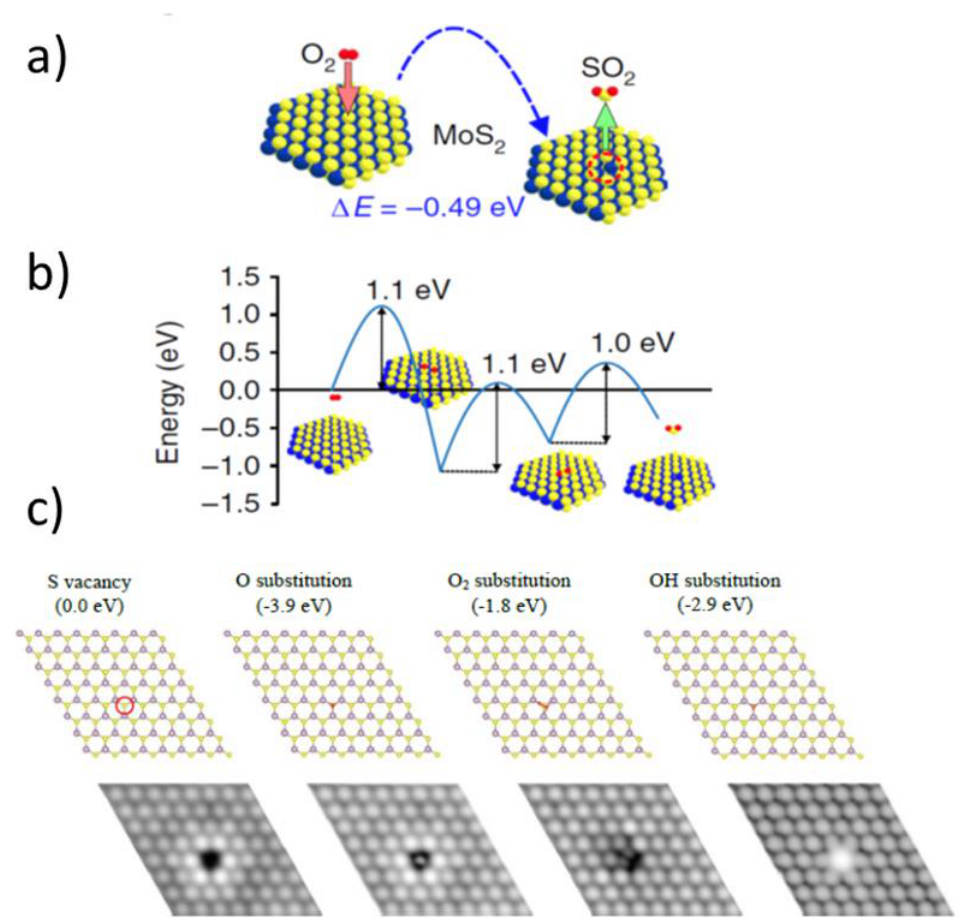
Figure 14. Energetics and kinetics of single sulfur vacancy creation and its later O substitution within the MoS 2 basal plane obtained by Peto et al. [60]. ( a ) The process of chalcogenide atom vacancy formation through oxidation is characterized by a negative oxidation enthalpy of − 0.49 eV. ( b ) Corresponding kinetic energy barriers calculated by the NEB model revealed barriers of ~1 eV. ( c ) O saturation of the SSV yields the ~4 eV energy gain, indicating the highly favorable nature of the O substitution process as a next step, in accordance with experimental STM findings. Reprinted by permission from Springer Nature Customer Service Centre GmbH: Springer Nature, Nature Chemistry [60] (2018).